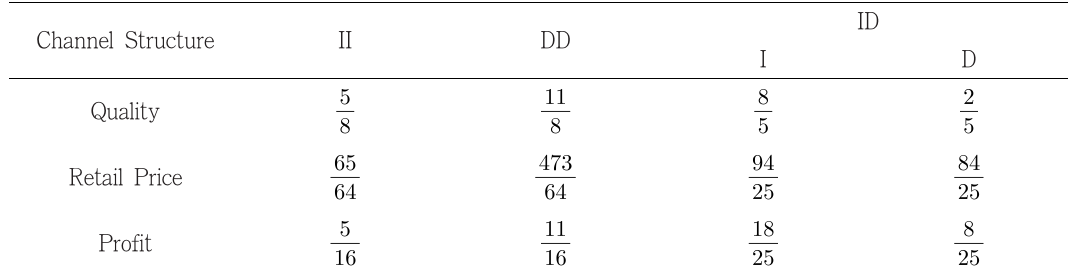
<Table 1> Outcomes of Quality, Retail Prices, and Retailers’ Profits under the Three Distribution Channel Structures in the Simultaneous-Channel-Choice Model (when the market is covered,  is sufficiently